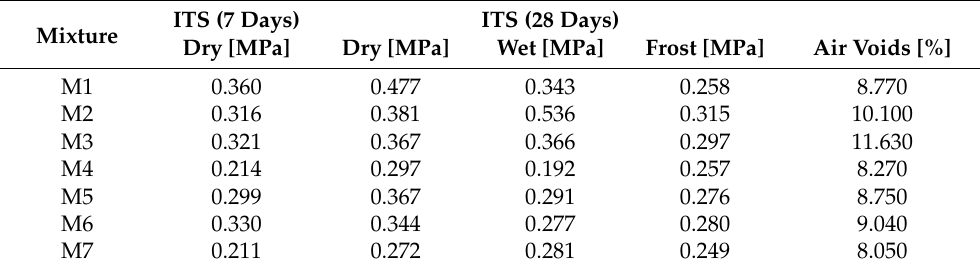
Table 5. Mean values of Indirect Tensile Strength for all